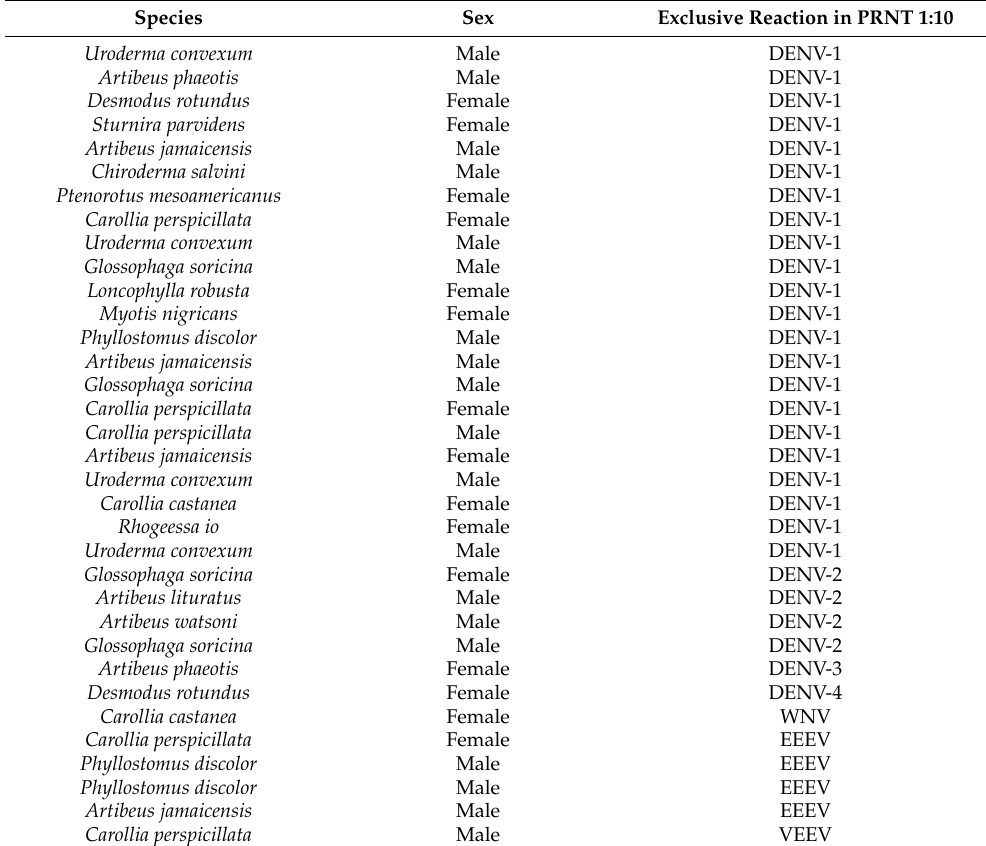
Table 2. Species of bats with neutralizing antibodies exclusive (specific) against Flaviviruses or Alphaviruses at PRNT 1:10 dilution.